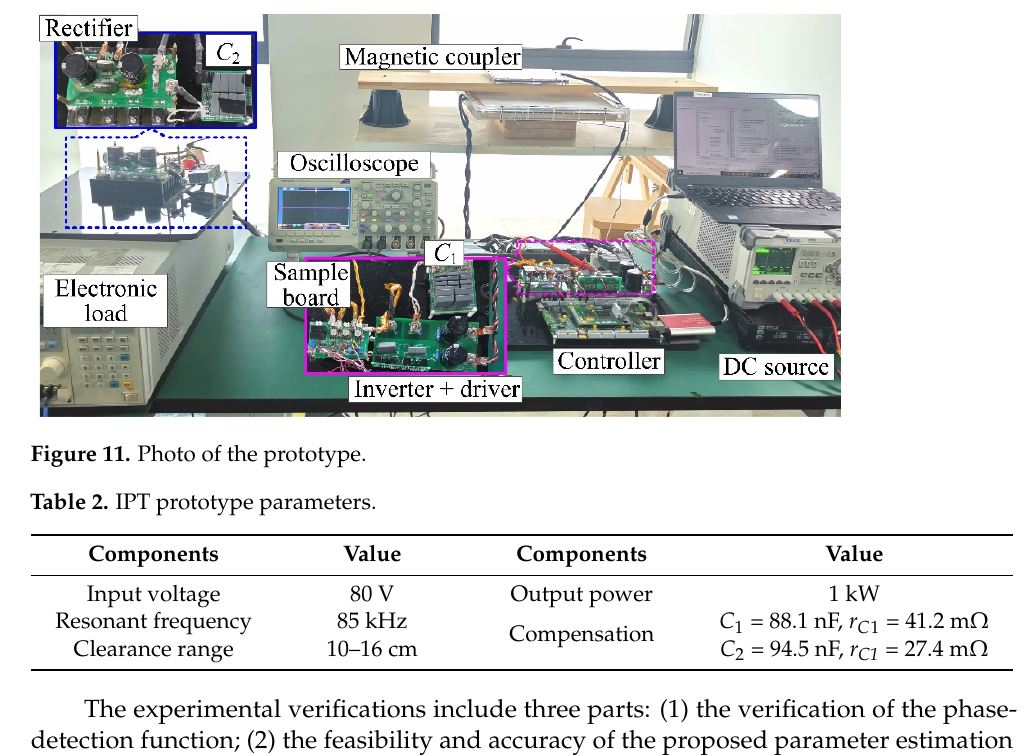
( b ) Figure 10. Zero coupling position of M 23 at a clearance of ( a ) ∆ Z = 10 cm and ( b ) ∆ Z = 16 cm. 5. Experimental Evaluation and Discussion 5.1. Experimental Prototype To verify the above analysis, a 1 kW prototype was built and tested in the laboratory. Figure 11 shows the experimental setup for the built prototype. The system parameters are listed in Table 2. The variable frequency range is from 85 kHz to 100 kHz. Q 1 ~Q 4 are